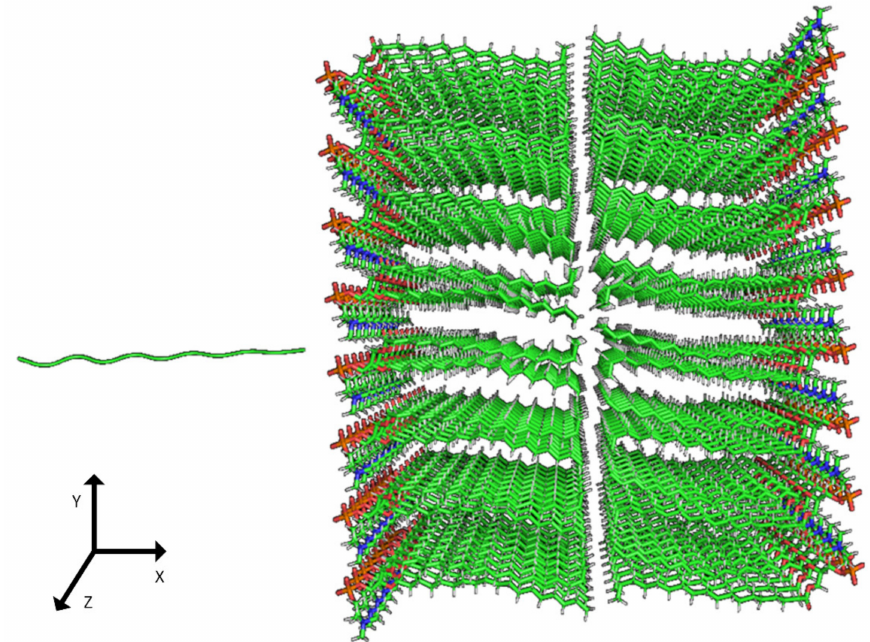
Figure 2. Phospholipid bilayer consisting of 8 × 8 × 2 = 128 molecules of POPC. The addition of the peptide was completed perpendicular to the plane of the